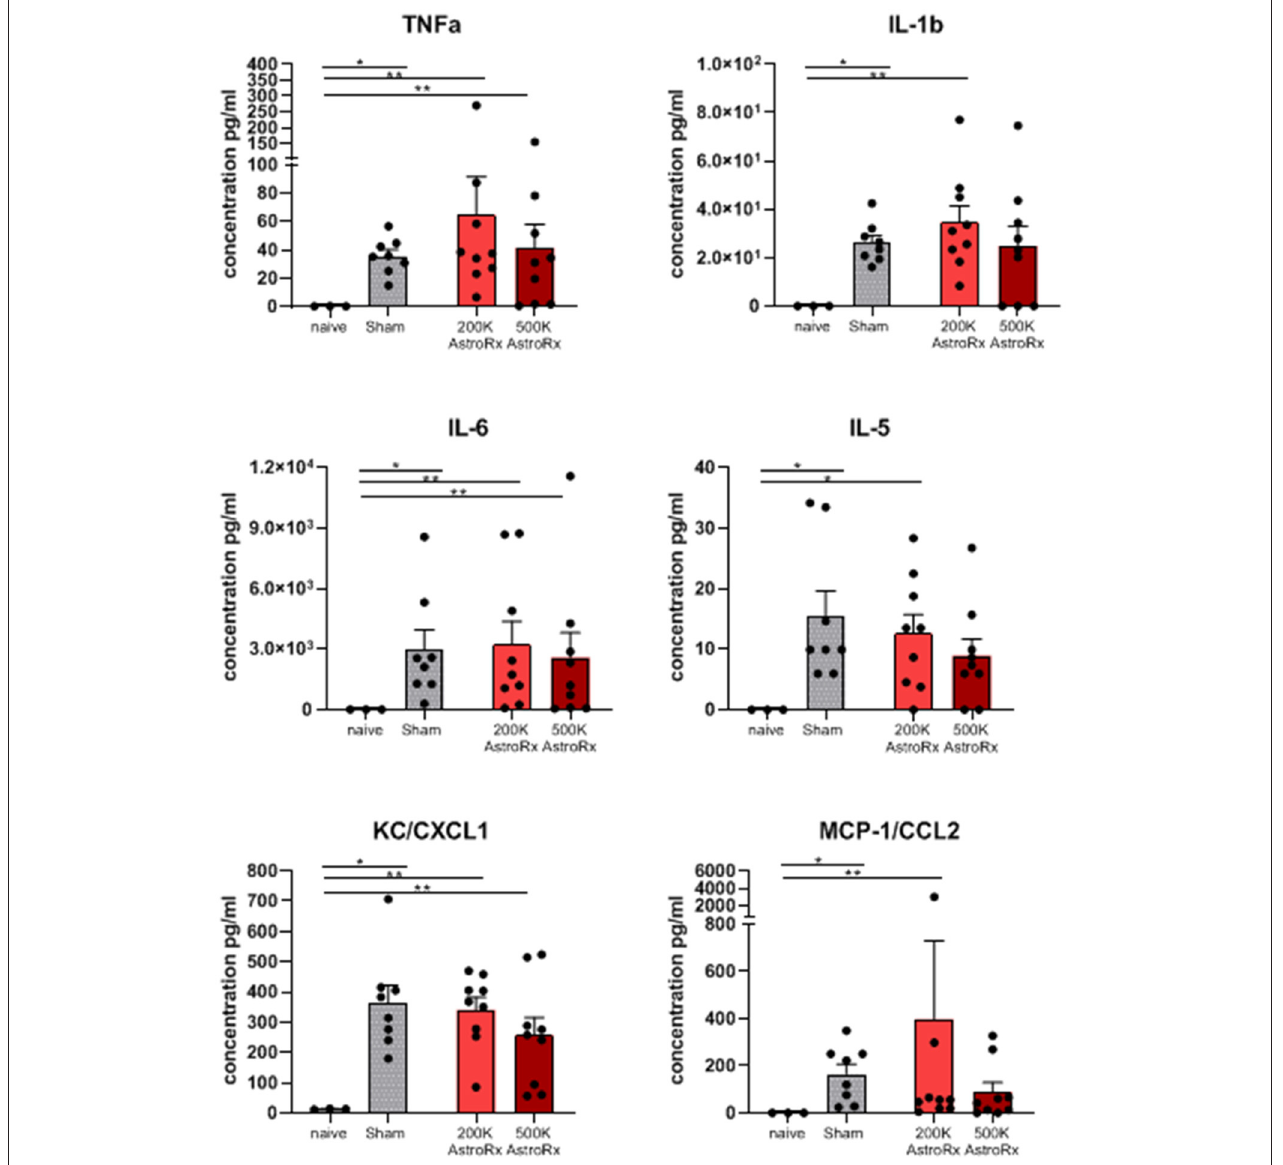
FIGURE 5 | Inflammatory cytokines/chemokines in lungs. The cytokines and chemokines in the BALF were quantified by ELISA (enzyme linked immunosorbent assay). The value of n = 10 mice for each experimental group (sham and both the groups of AstroRx treated mice) and n = 4 for naïve mice, the results are expressed as mean ± SEM. The Mann–Whitney comparison test. * p < 0.05; ** p < 0.01; Naïve vs. sham: * p = 0.0121, naïve vs. 200K or 500K astrocytes p = 0.0091 (TNFa, IL-6, CXCL1, and CCL2) and * p = 0.0318